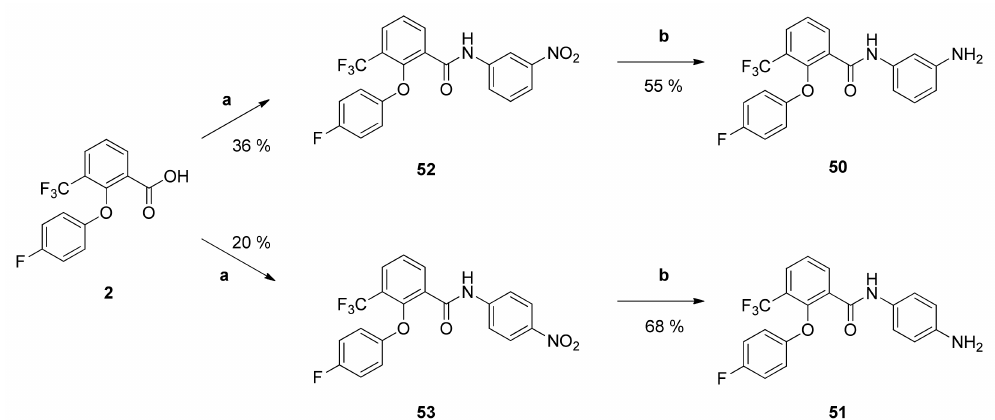
Figure 6. Preparation of compounds 50 and 51 . Reagents and conditions: ( a ) (1) 3-nitroaniline, CH 2 Cl 2 , 0 ◦ C, 5 min; (2) 2-chloro- N -methylpyridinium iodide, DIPEA, rt, 48 h (compound 52 ) or (1) 4-nitroaniline, CH 2 Cl 2 , 0 ◦ C, 5 min; (2) 2-chloro- N -methylpyridinium iodide, DIPEA, rt, 24 h (compound 53 ); ( b ) 15% (m/m) palladium on activated carbon, H 2 , Me OH, rt, 24